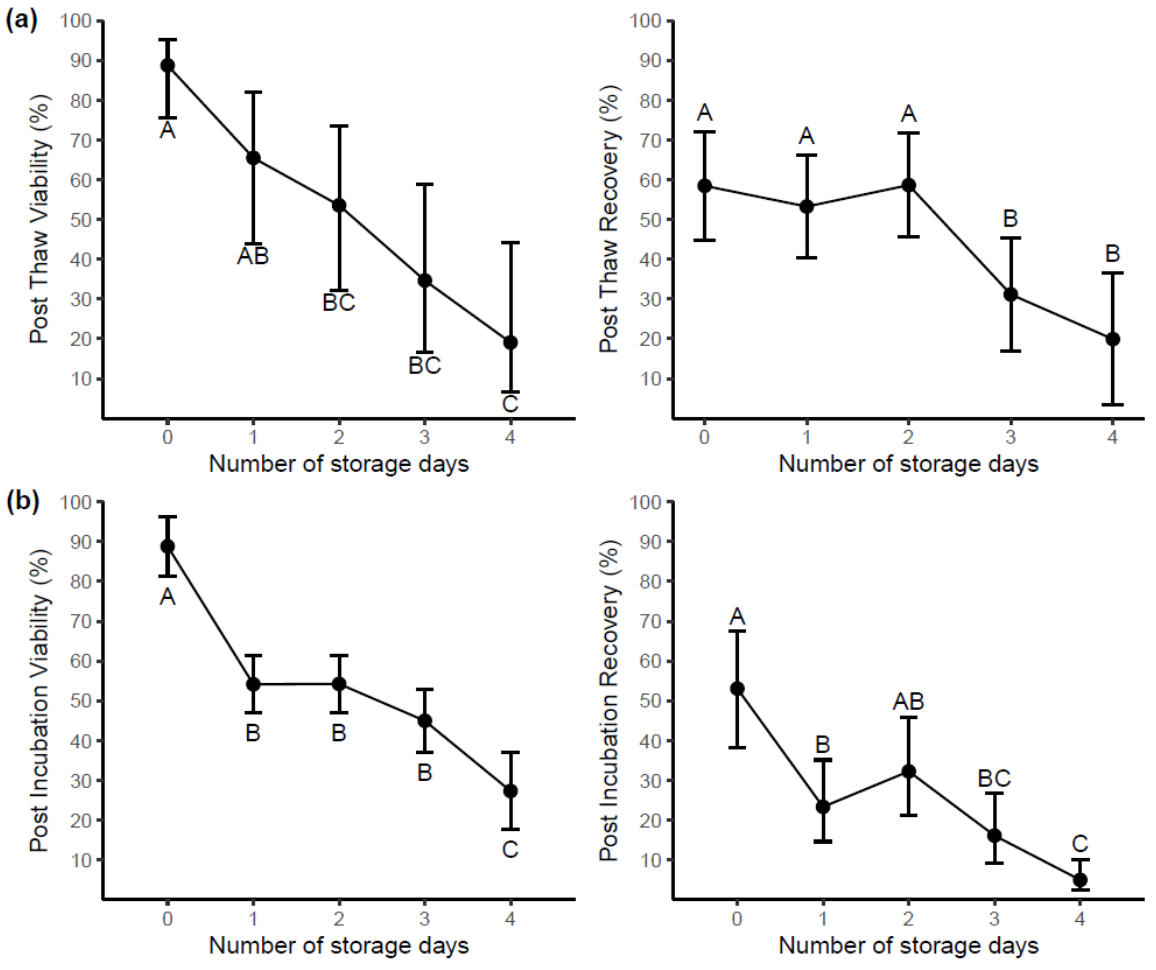
Figure 2. The impact of delaying blood processing on samples (n = 10). Cells were prepared for cryopreservation at a cell density of 10 × 10 6 cells/mL. ( a ) Post-thaw viability and recovery of samples stored for up to 4 days prior to processing. ( b ) Post-incubation (overnight at 37 ◦ C) viability and recovery of samples stored for up to 4 days prior to processing. Day 0 represents the day of collection. Each point represents the predicted mean with 95% CI. Letters (A, B, C) indicate groups (Tukey’s test), where predicted means that are not significantly different are labeled with the same letter. No significant differences between 4 C and RT were found, therefore storage day means only are shown.